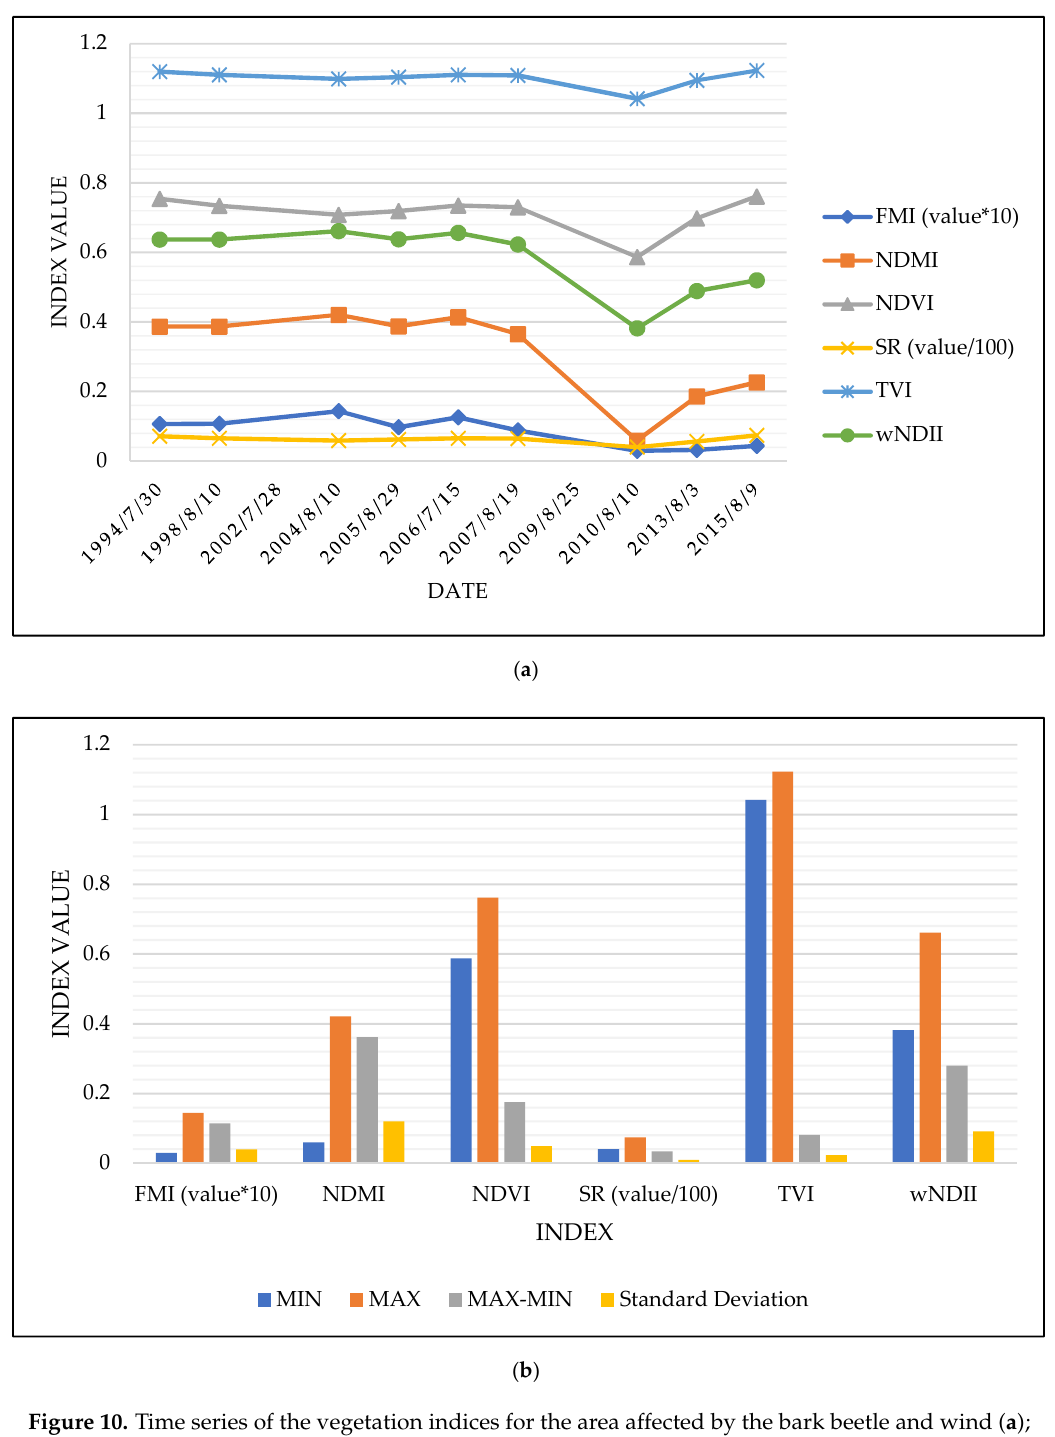
Figure 10. Time series of the vegetation indices for the area affected by the bark beetle and wind ( a ); and the statistical information ( b ) (Locality 6) (Source: Own work).